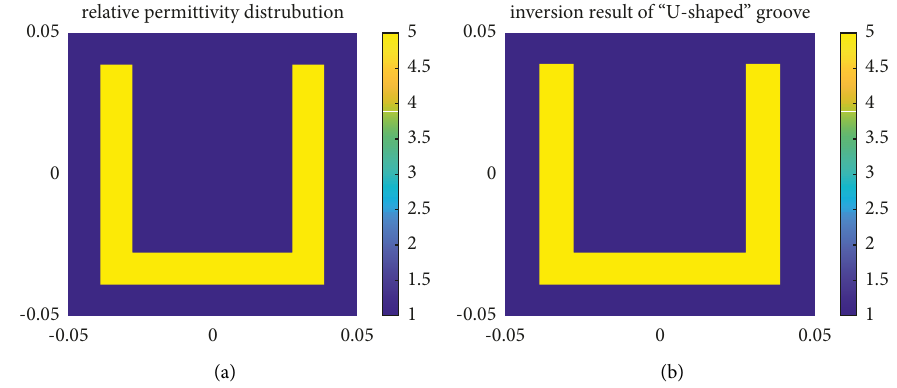
Figure 3: Comparison results of the relative permittivity distribution of the “U-shaped” groove.